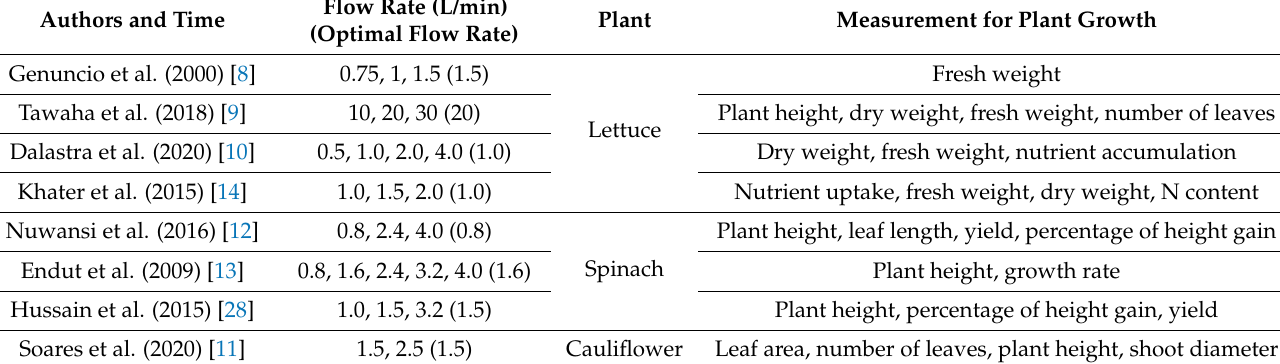
Table 3. Studies regarding the effect of flow rate on plant growth in